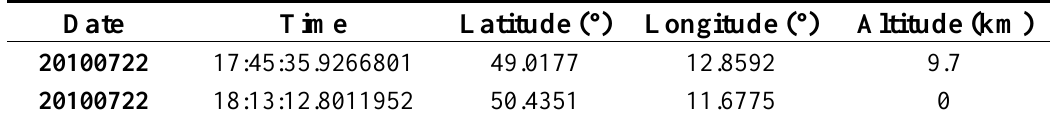
Table 1. Example of the provided lightning data.